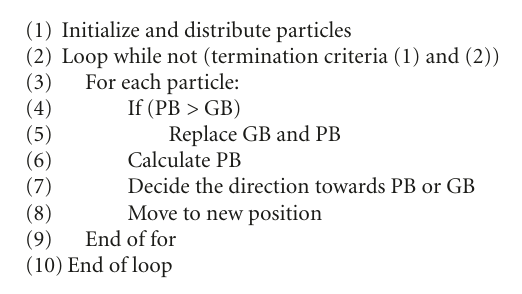
Algorithm 1: Generalized PSO